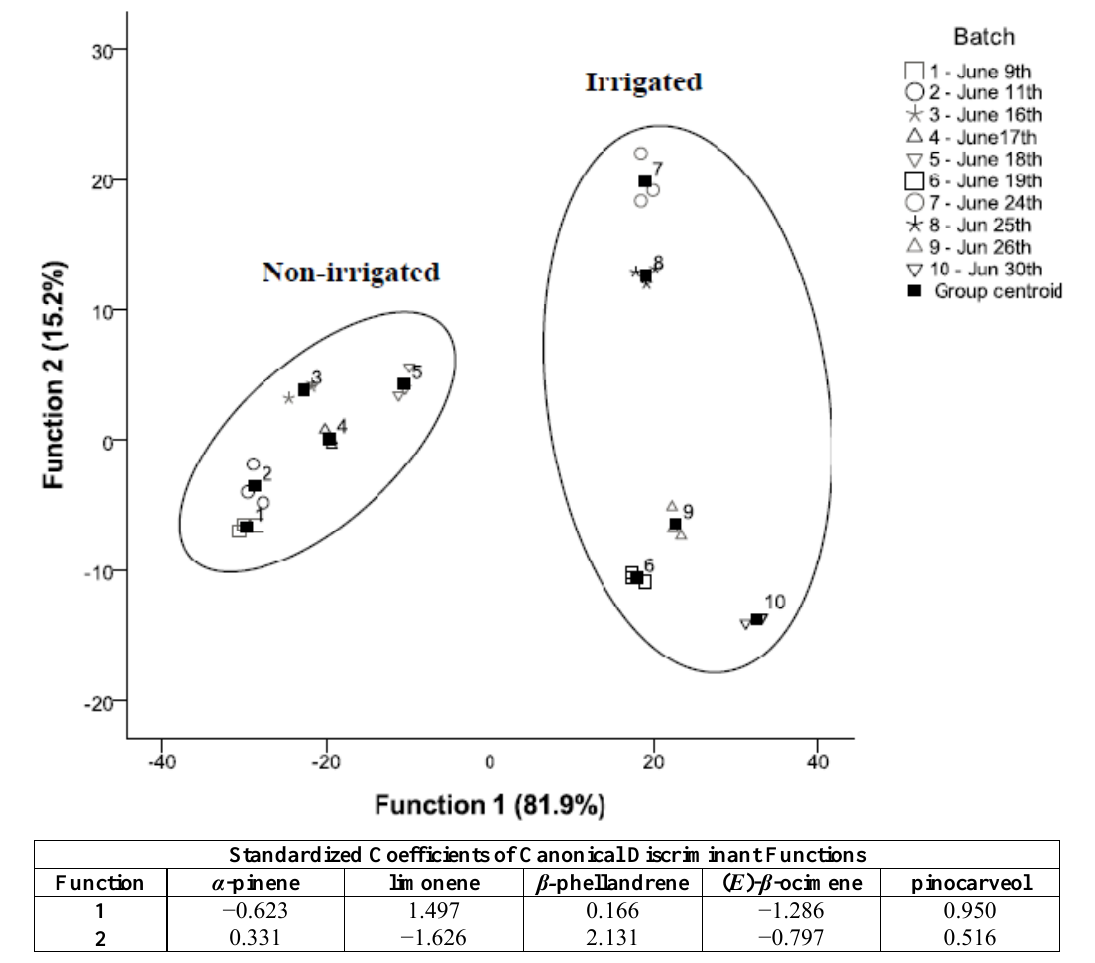
Figure 2. Application of discriminant analysis to the data expressed as data harvest of different